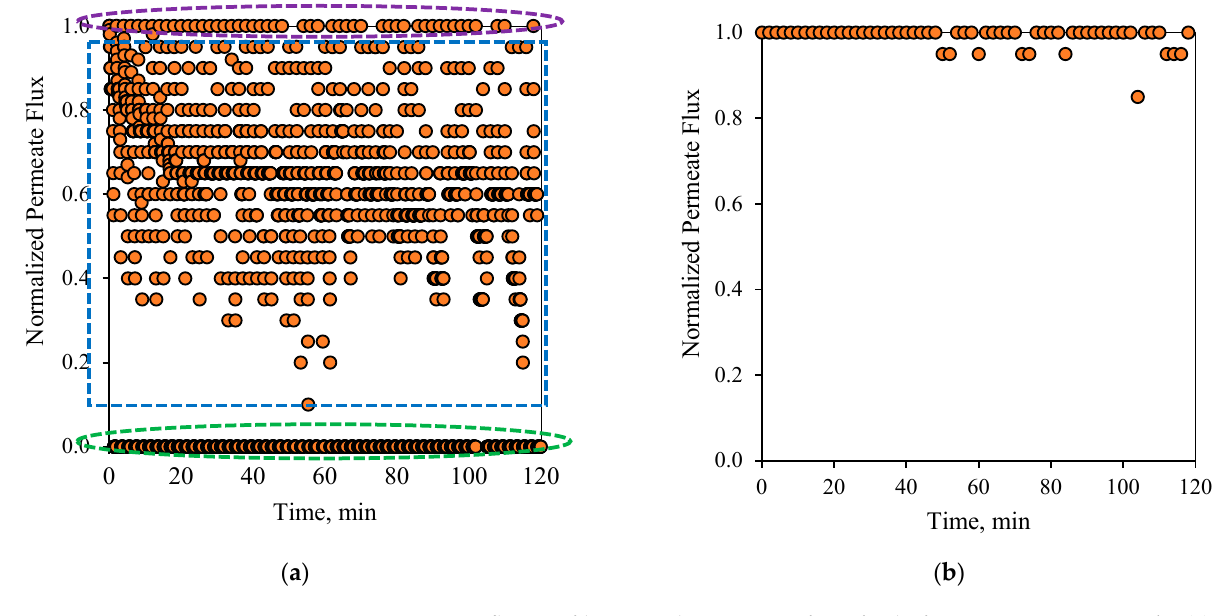
Figure 6. Permeate flux profile using the 1-1 PFPT for a feed of 100 ppm at CFV: 1 m/s: ( a ) PFPT filtration mode, ( b ) membrane permeability after each cleaning half-cycle. (1) region 1 (purple), (2) region 2 (blue), (3) region 3 (green).